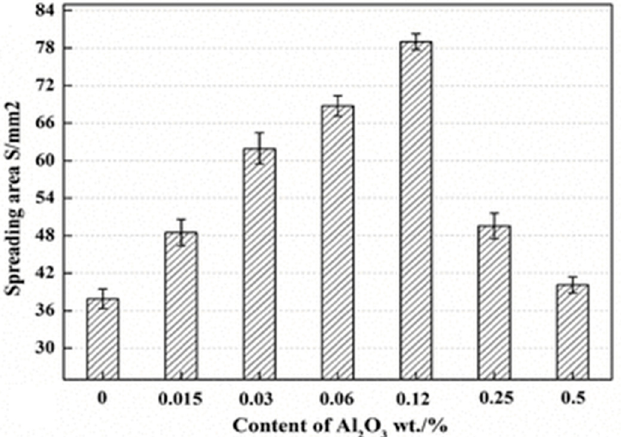
Figure 4. Spreading areas of SnAgCu–nano Al 2 O 3 composite solder [39].